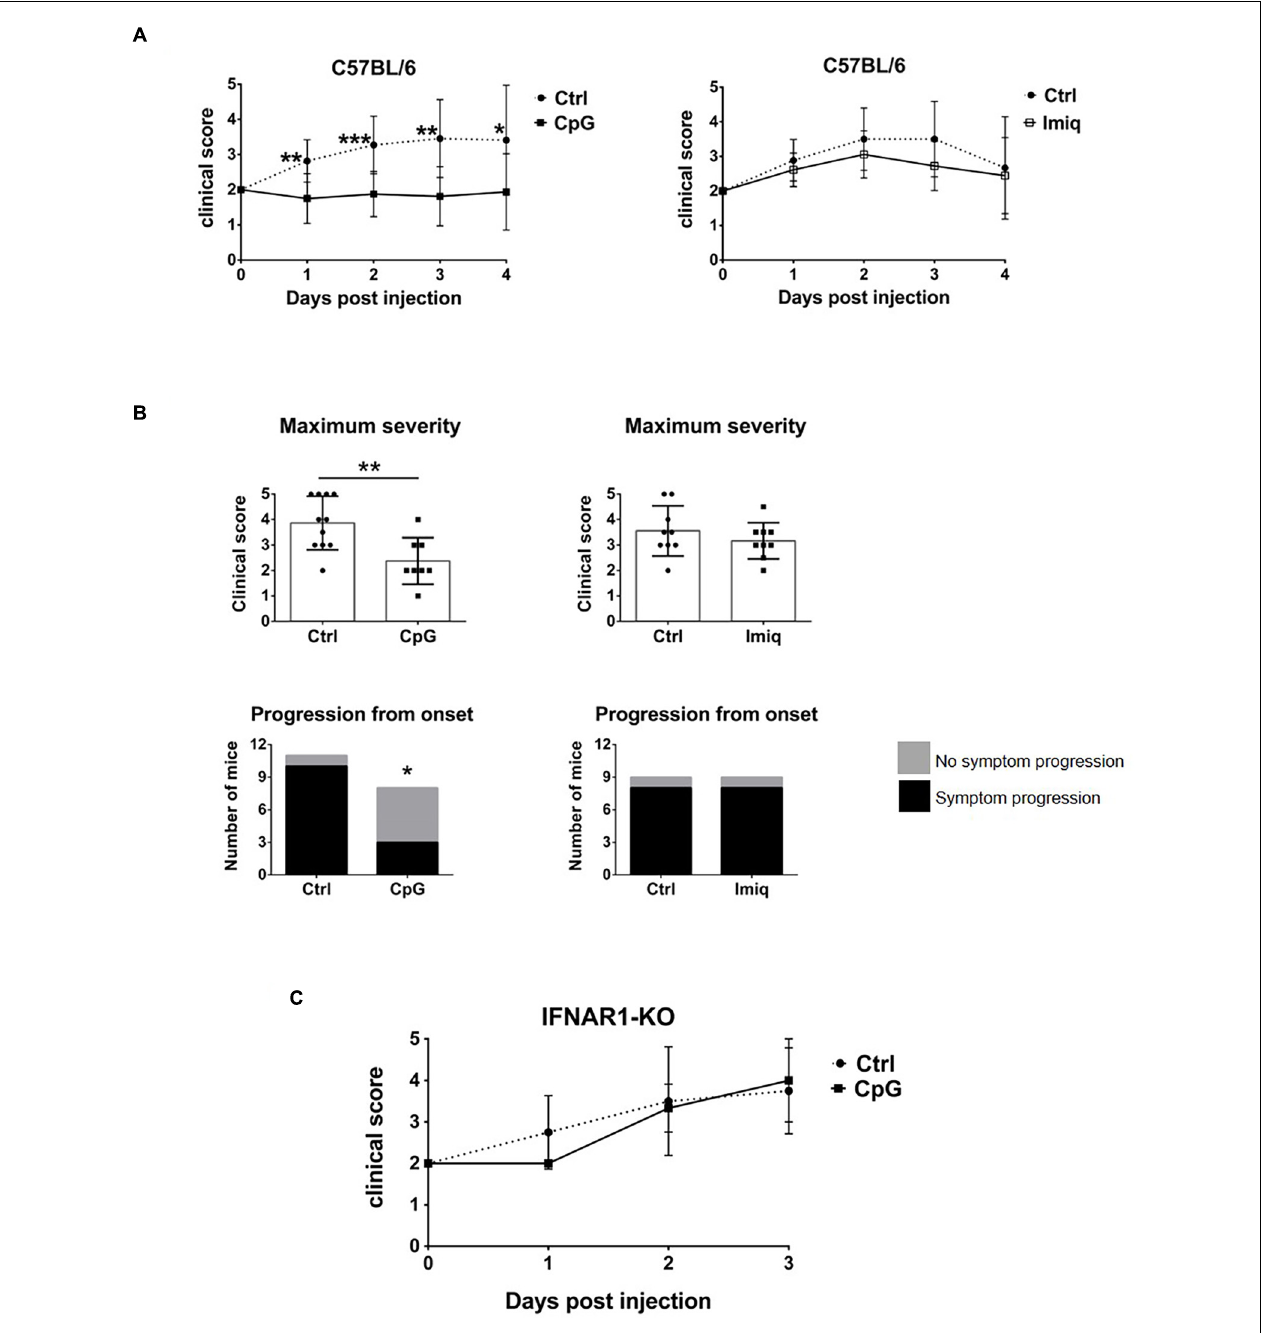
FIGURE 5 | Intrathecal CpG, but not Imiquimod, suppressed EAE in an IFNAR-dependent manner. Mice were immunized with MOG35-55 to induce EAE and at disease onset (day 0) they received intrathecal CpG or Imiquimod (Imiq). Symptoms were scored daily until day 4. (A) Clinical scores of C57BL/6 mice with EAE treated with intrathecal CpG or Imiquimod ( n = 8–11 per group). Results were analyzed using the two-tailed Mann–Whitney U -test (comparing two groups at a given day). (B) Maximum severity based on the highest clinical score of each mouse and clinical scores of mice whose symptoms progressed or not after treatment at day 0. CpG treatment significantly reduced EAE severity as well as the number of mice that progressed after onset ( n = 8–11 per group). Results were analyzed using the two-tailed Mann–Whitney U -test (top graphs) and Fisher’s exact test (bottom graphs). (C) IFNAR1-KO mice with EAE were treated with intrathecal CpG ( n = 3–8 per group). Data are presented as means ± SD. * p < 0.05; ** p < 0.01; *** p < 0.001.